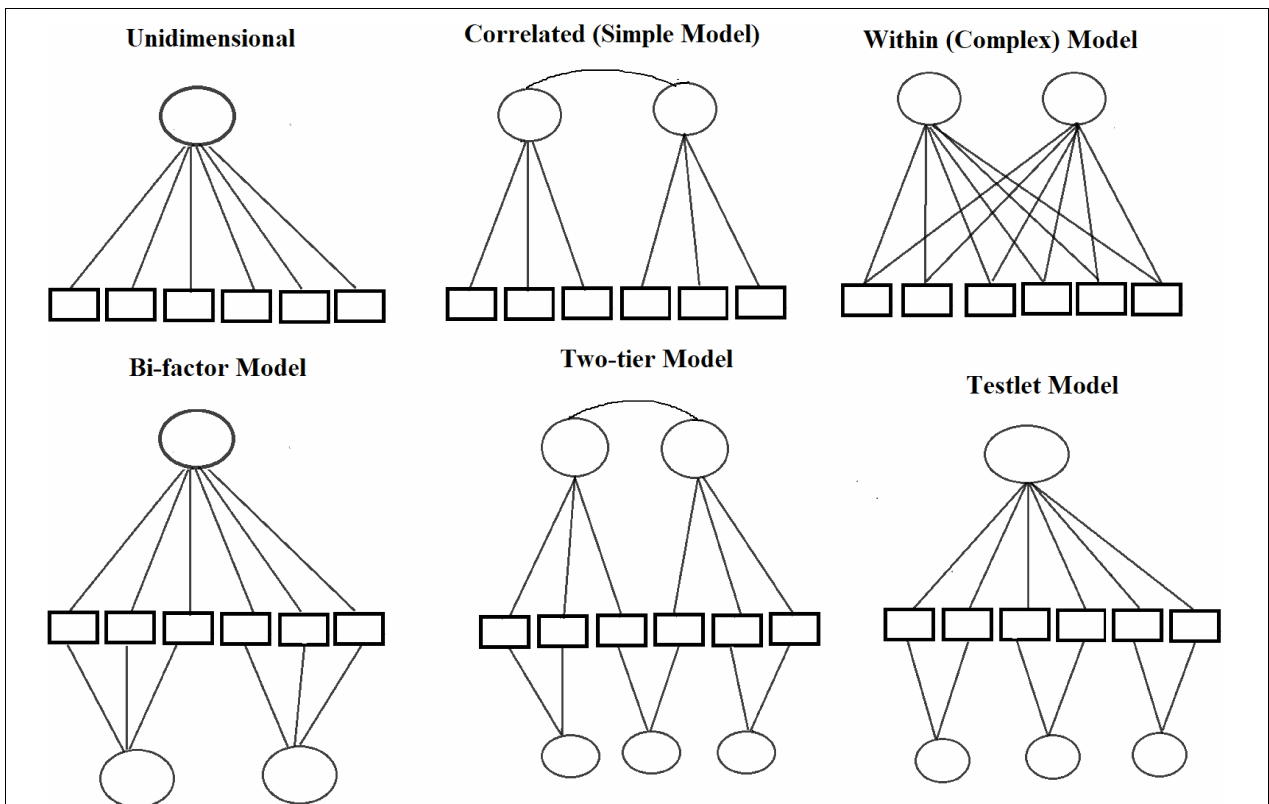
FIGURE 1 | The representing of the structural models which used in the